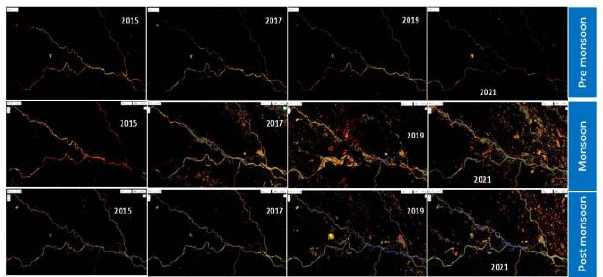
Figure 3. Temporal changes in water extent in river system